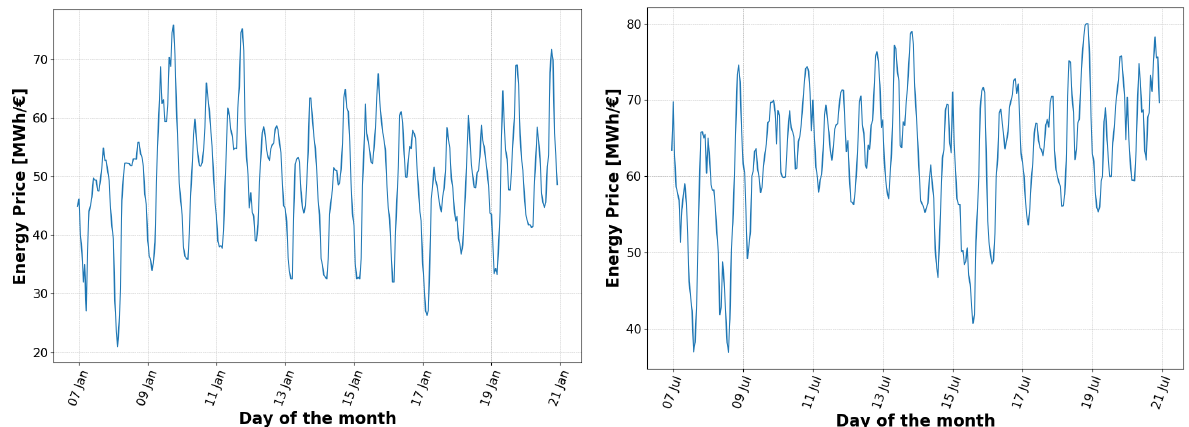
Figure 7. ( left ) Wholesale energy market price trends for the weeks from 7 to 21 January 2019. ( right ) Wholesale energy market price trends for the weeks from 7 to 21 July